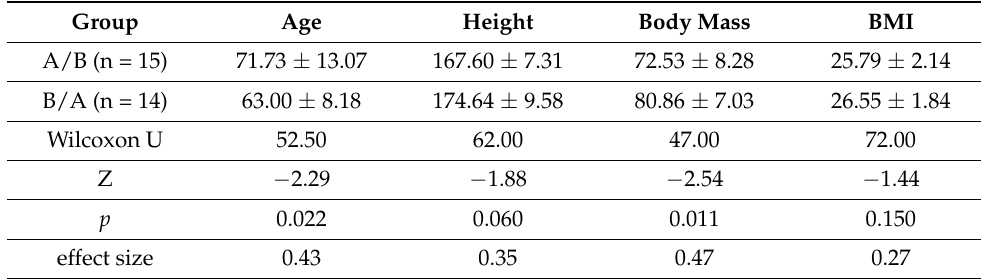
Table 1. Biometric data of study population and clinical control group.